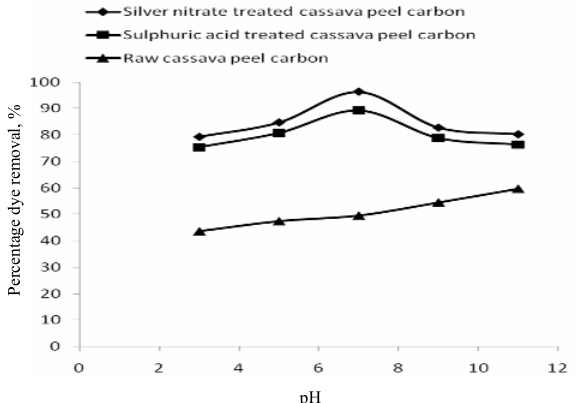
Figure 3. Effect of pH on methyl red